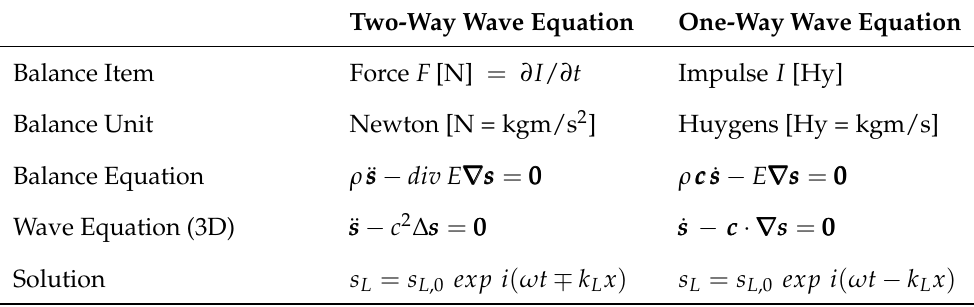
Table 1. Comparison of force based Two-Way Wave Equation and impulse based One-Way Wave Equation in an unlimited, elastic 3D contiuum without boundary effects. For simplicity and clarifi- cation linearity, homogeneity, isotropy and losslessness are assumed; sss [m] = elastic displacement, ˙ sss = ∂ sss / ∂ t [m/s] = particle velocity; a ba ba b , aaa × bbb , aaa · bbb = dyadic, vectorial, scalar product of the two vectors aaa and bbb